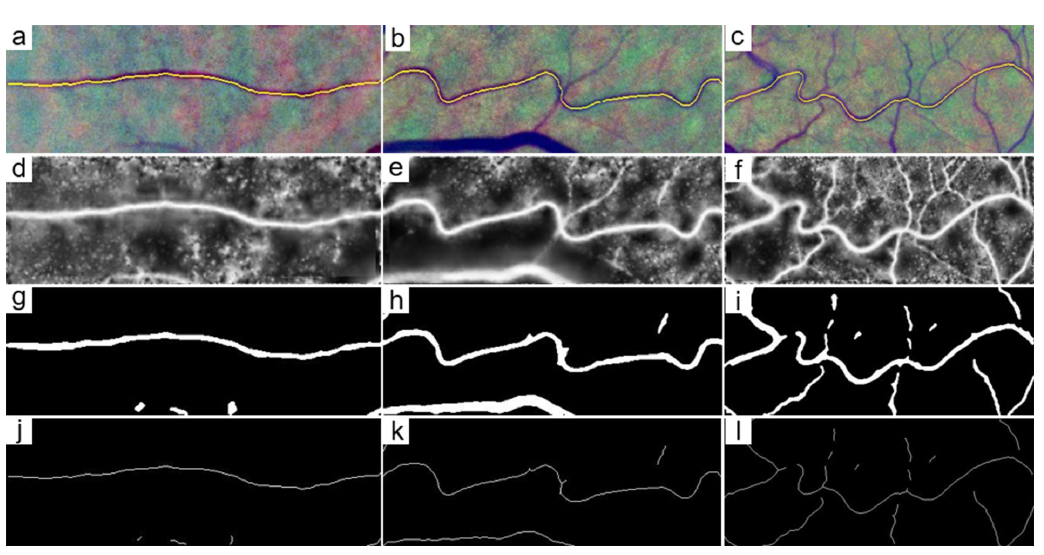
Figure 5. RET-TORT dataset images and pre-processing steps; ( a – c ) are original vessels images with manual labeled ground truth; ( d – f ) are images enhanced by local phase tensor filters; ( g – i ) are segmentation results by IPACHR; ( j – l ) are skeletonization of